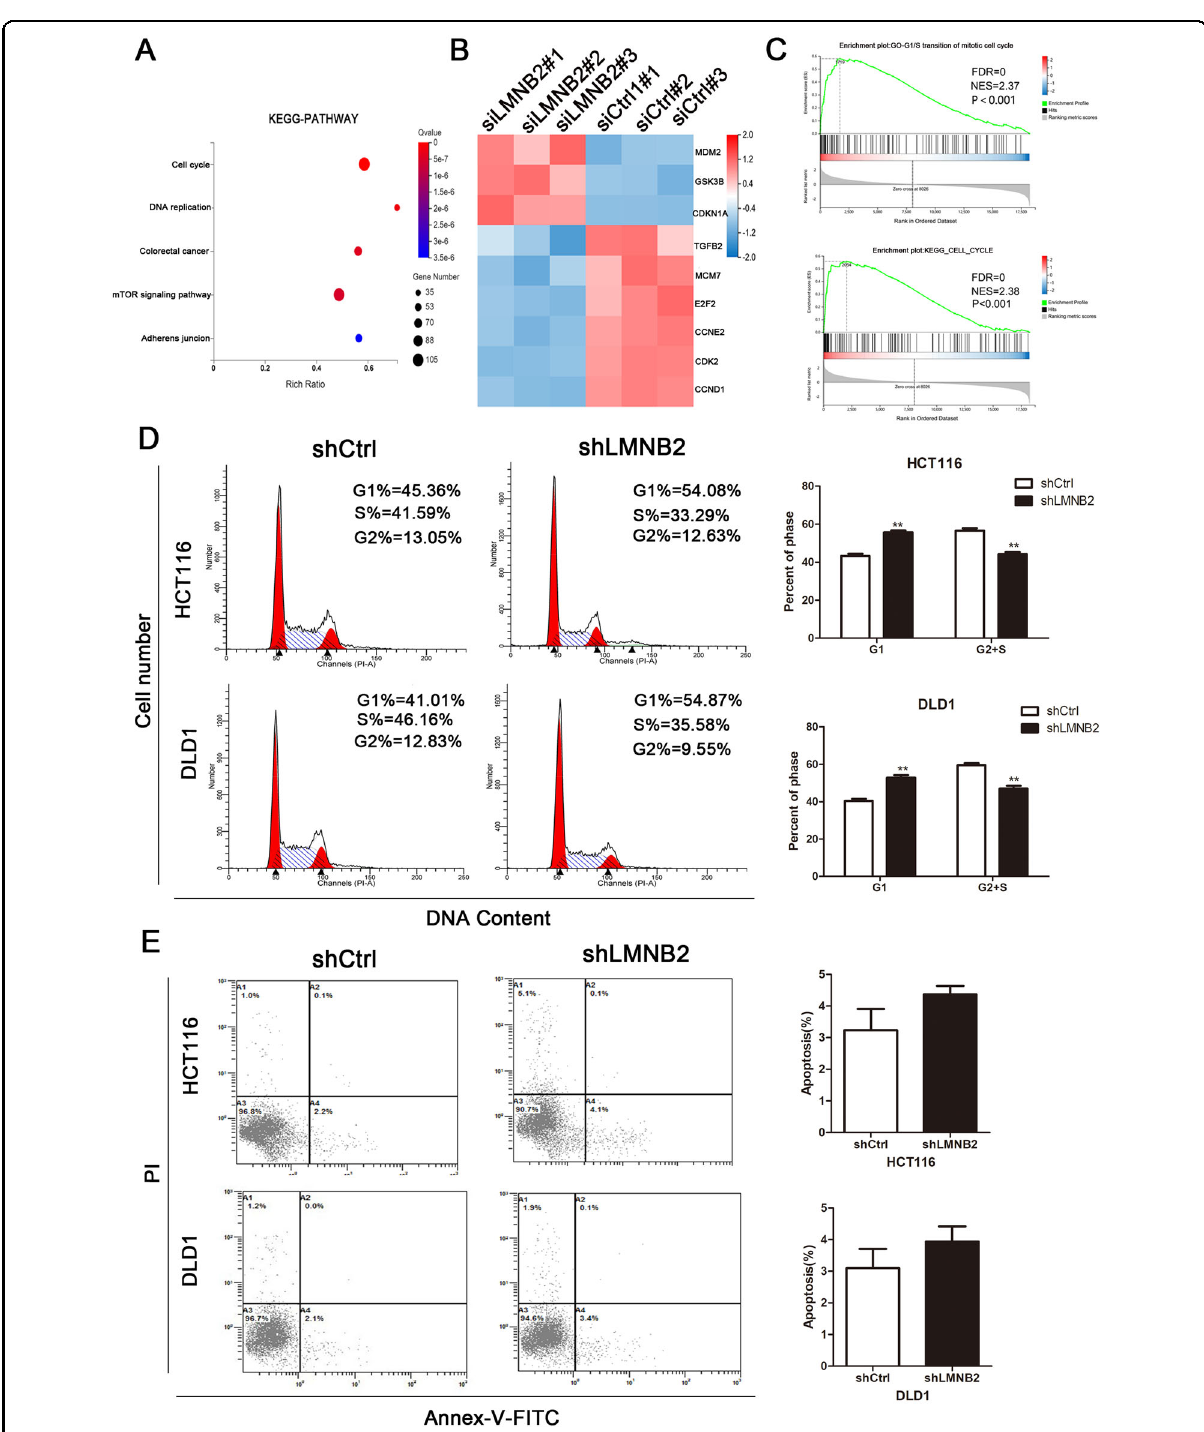
Fig. 3 LMNB2 can accelerate the cycle of colorectal cancer cells, but has no effect on cell apoptosis. A Kyoto Encyclopedia of Genes and Genomes pathway analysis was performed for screening DEGs using the PANTHER database. B Heat map of differentially expressed genes after LMNB2 gene knockout. C GSEA analysis showed that the LPCAT1 ampli fi cation status was positively correlated with genes related to “ KEGG CELL CYCLE ” and “ GO CELL CYCLE G1-S TRANSITION ” . D Flow cytometry analysis after Annexin – FITC and PI staining found that after LMNB2 gene knockout, the number of cells in G0/G1 phase increased, whereas the number of cells in S phase and G2 phase decreased. E Flow cytometry analysis and Annexin PI staining results showed that LMNB2 gene knockout had no signi fi cant effect on the apoptosis of colorectal cancer cells. All experiments were performed independently three times. The data are the mean ± SD. * P < 0.05, ** P < 0.01, * P < 0.001.